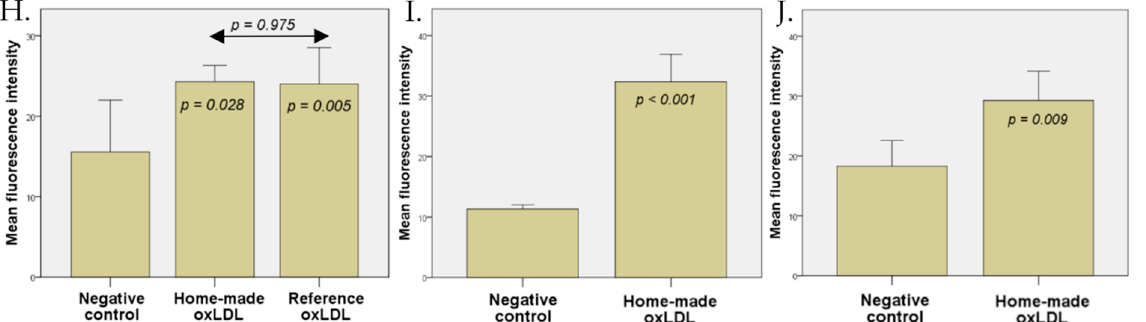
Figure 3. CD36 expression in 93VU-147T, UM-SCC47, and UPCI-SCC154 cell lines with or without oxLDL treatment (30 µg/mL, 48 h). Representative images and computed mean fluorescence inten- sities (MFI; 2 biological replicates in triplicate). ( A , H ) CD36 expression in 93VU-147T not exposed to oxLDL ( n = 10); ( B , H ) or exposed to home-made oxLDL ( n = 10); or ( C , H ) reference oxLDL ( n = 10). ( D , I ) CD36 expression in UM-SCC47 cells without oxLDL ( n = 10); or ( E , I ) exposed to home-made oxLDL ( n = 10). ( F , J ) CD36 expression on UPCI-SCC154 cells without oxLDL ( n = 10); or ( G , J ) with home-made oxLDL ( n = 10).